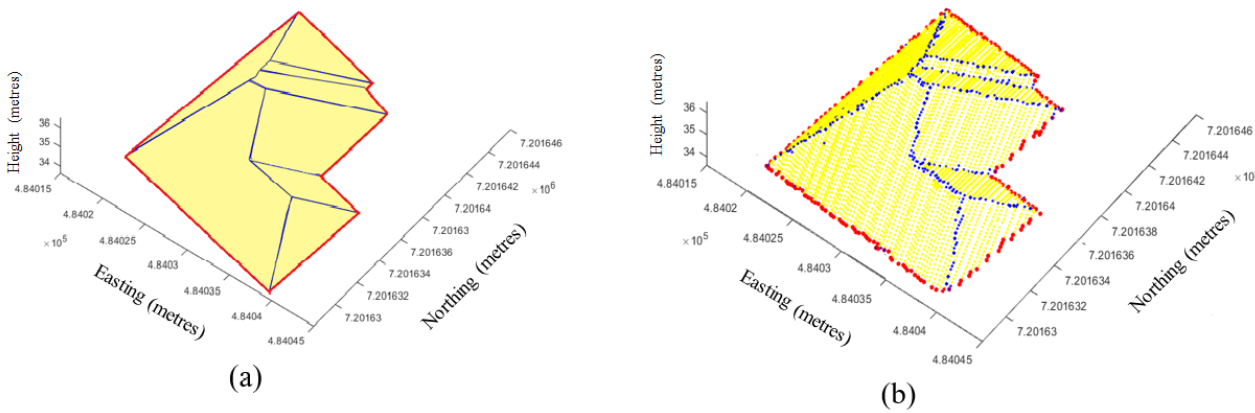
Figure 12. Combined fold (blue), boundary (red,) and planar (yellow) points compared with the reference 3D building roof [7] for a complex building from the HB dataset: ( a ) reference 3D building roof and ( b ) combined